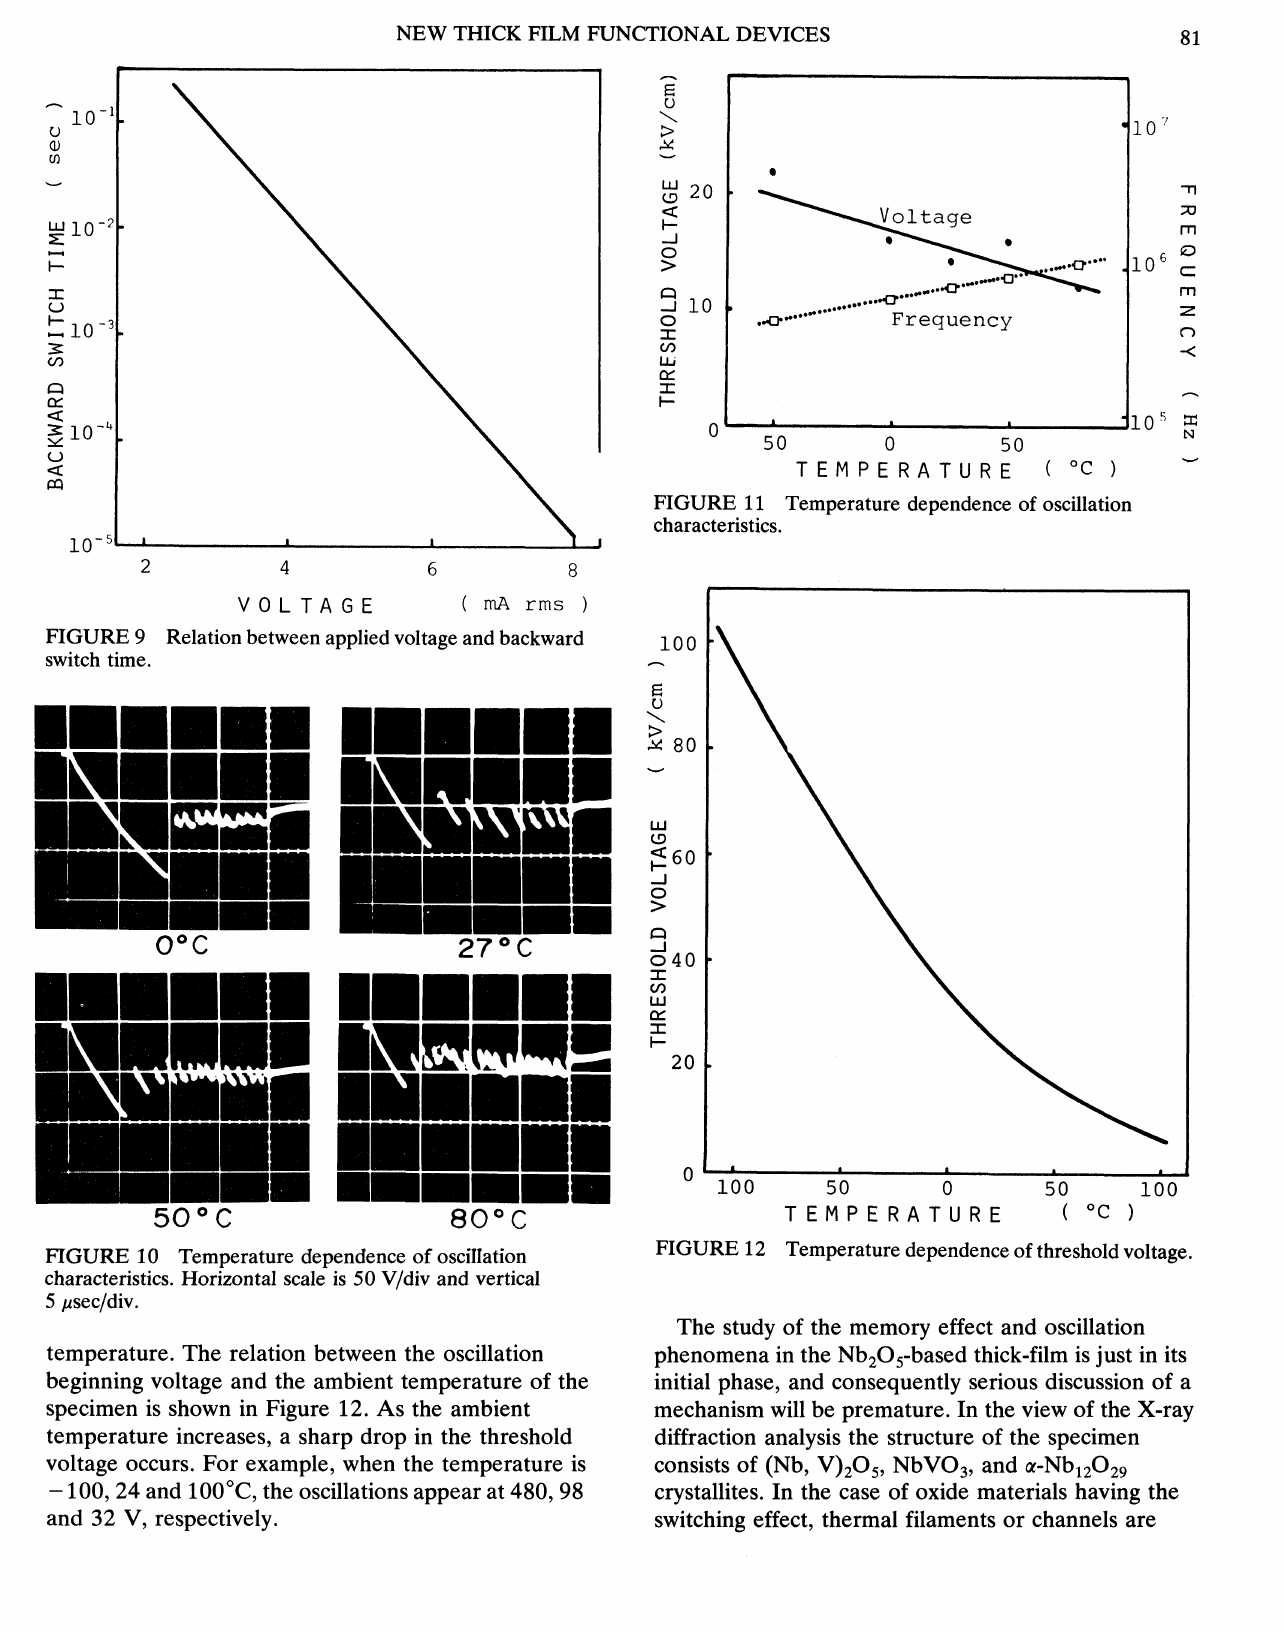
FIGURE 12 Temperature dependence of threshold